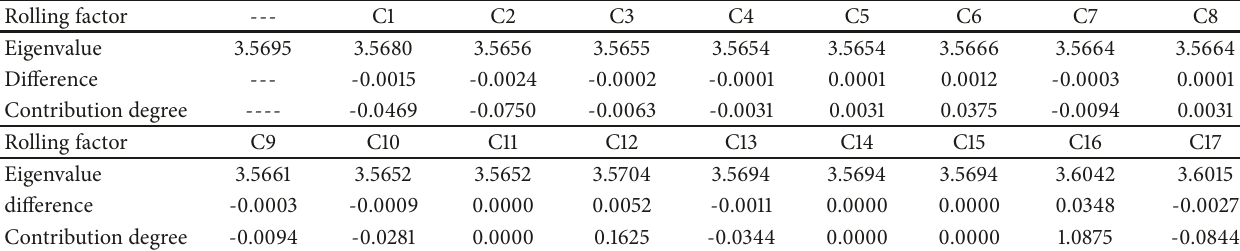
Table 8: Contribution degree of each factor in